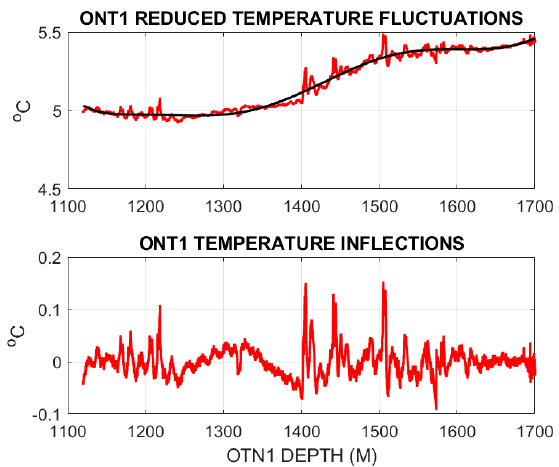
Figure 2. Reduced temperature log positive excursions ( Upper ) and deviations from local temperature trending ( Lower ) logged for the granitic rocks between 1120 and 1700 m in the OTN1 pilot well; in upper plot the black line denotes a polynomial fit to longer-term temperature trends. Short term temperature deviations in lower plot can be plausibly associated with independent local fracture-connectivity flow structures that intersect the wellbore at the given depths.